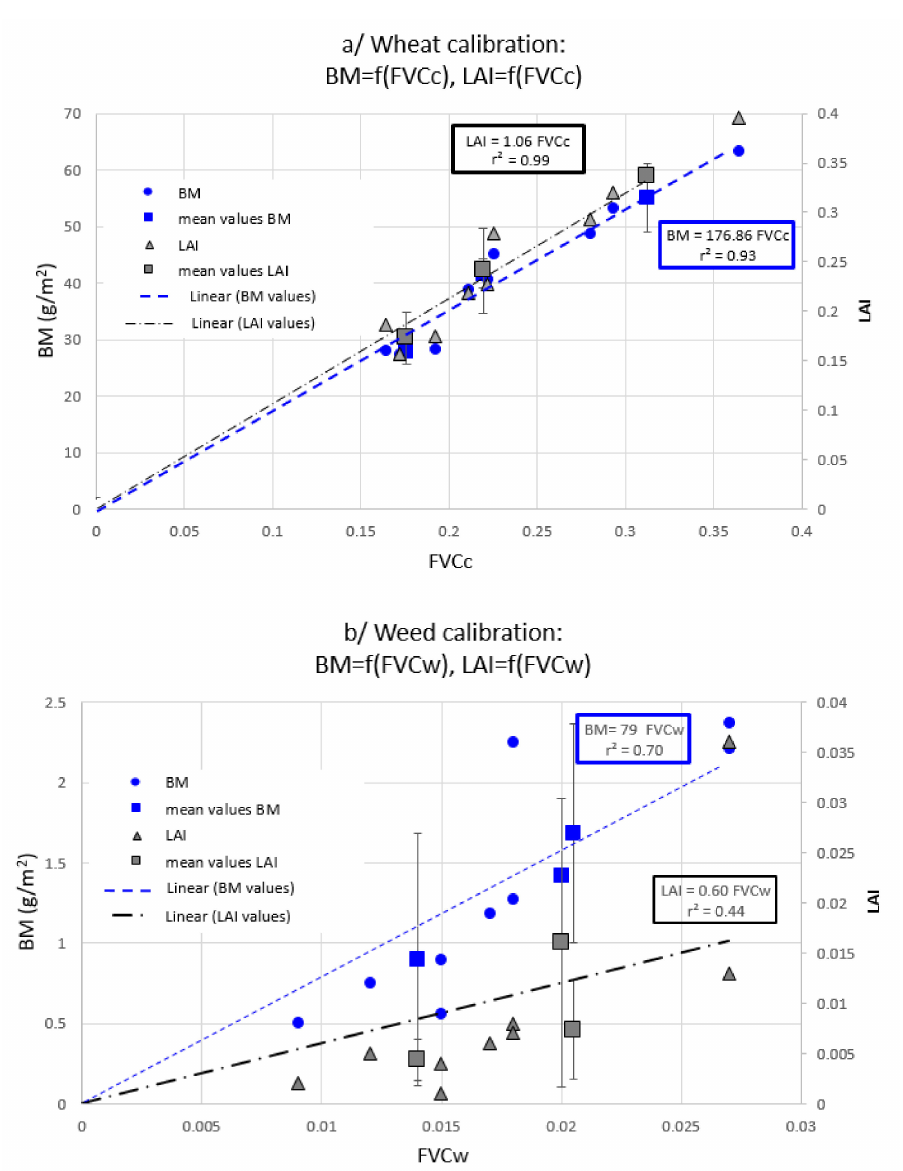
Figure 6. Linear regression between LAI and FVC (dashed black line) and between BM and FVC (dashed blue line) for ( a ) the wheat stand and ( b) the weed stand. There were three replicates on each date. The squares represent the mean values and the bars the standard